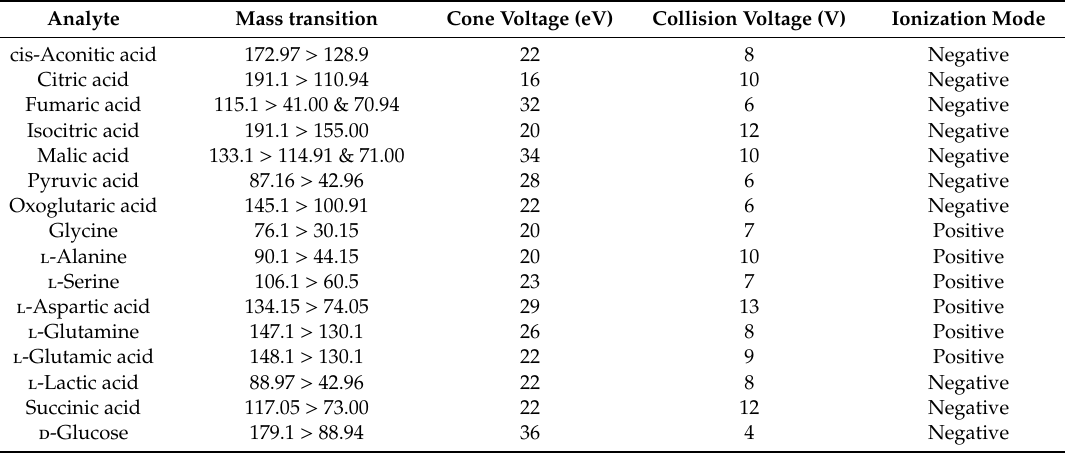
Table 4. Compound dependent